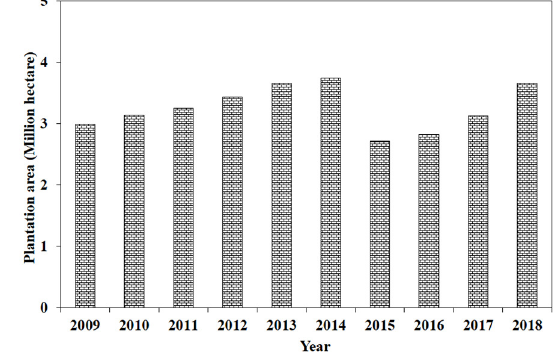
Fig. 7: Time profile of rubber tree plantation area in Thailand